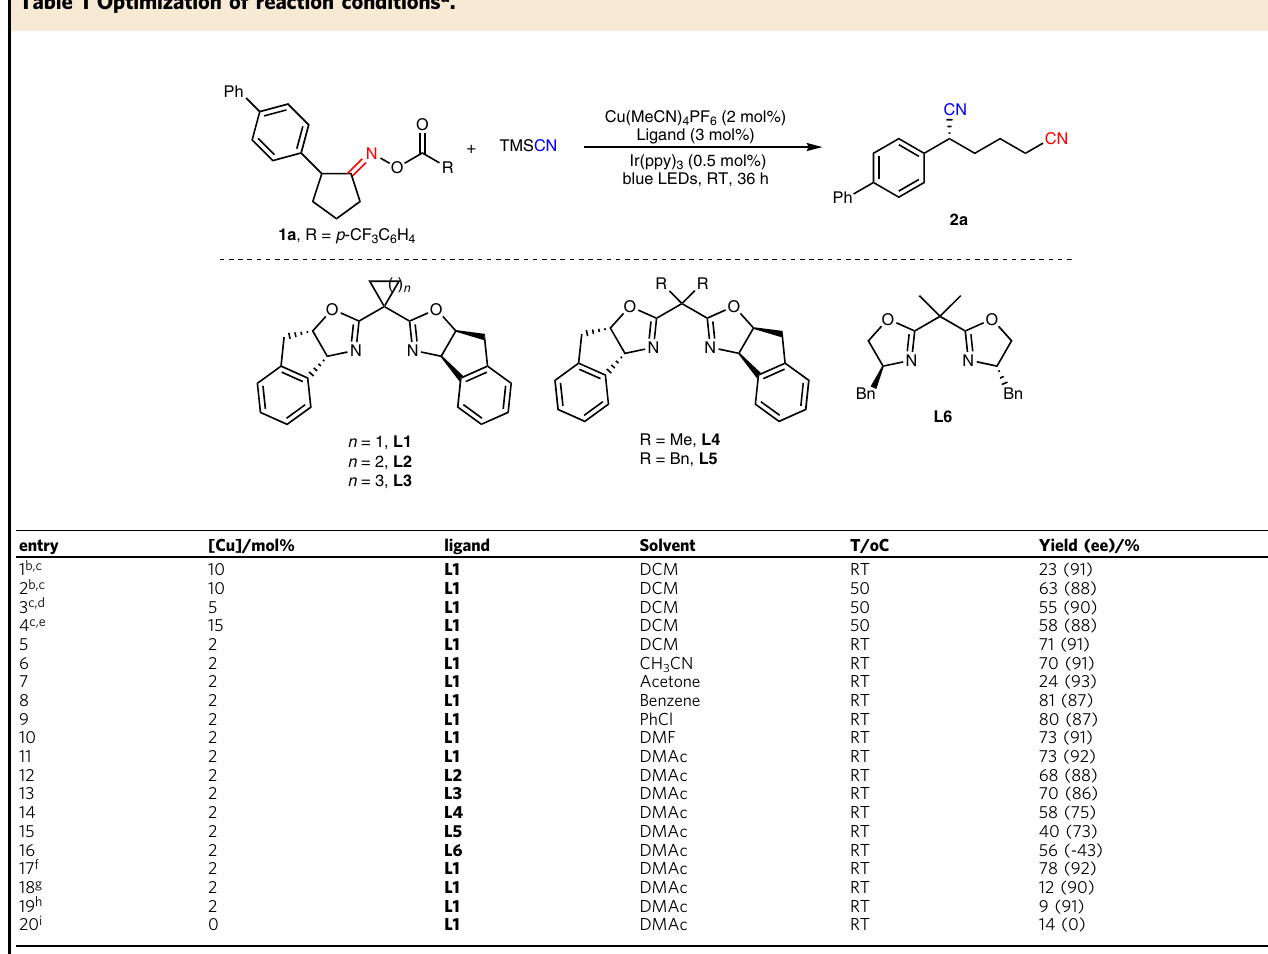
Table 1 Optimization of reaction conditions a